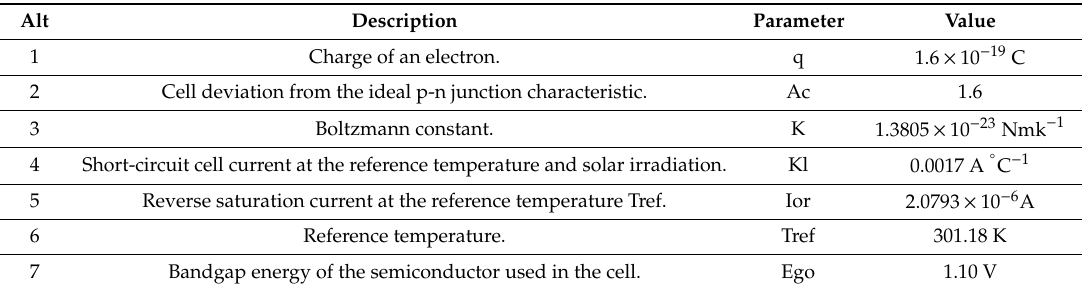
Table 1. Parameters used in the solar system.